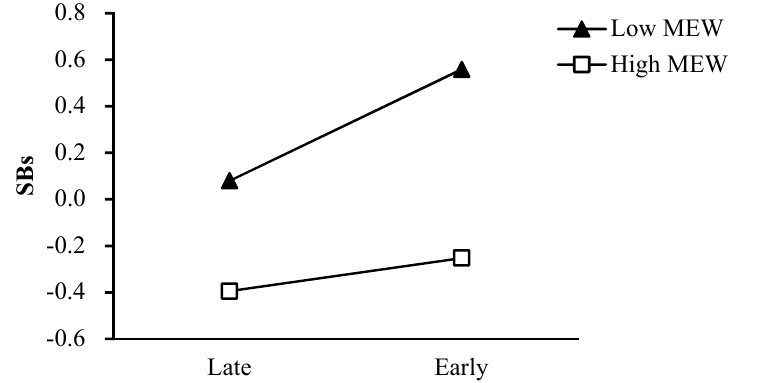
Figure 4. The two − way interaction between PT and MEW in predicting girls’ SBs. Note: PT pubertal Figure 4. The two−way interaction between PT and MEW in predicting girls’ SBs. Note: PT pubertal timing, MEW mother emotional warmth, SBs smoking timing, MEW mother emotional warmth, SBs smoking behaviors.